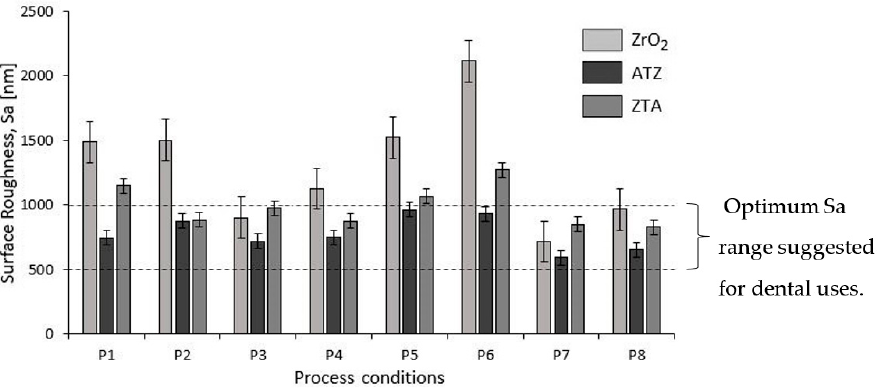
Figure 7. The surface roughness, Sa (nm), per material of the ground dental threads. (Table A1).